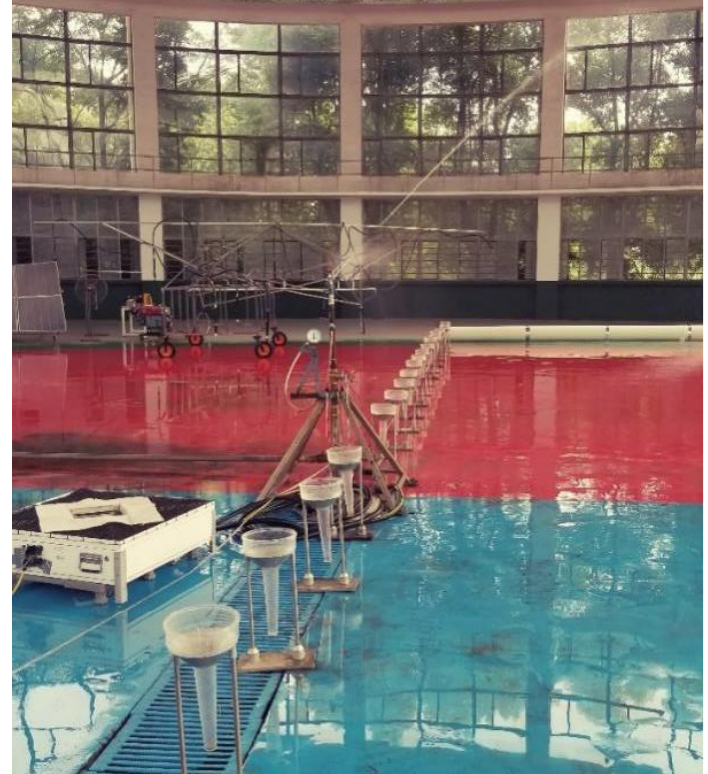
Figure 6. The test site.